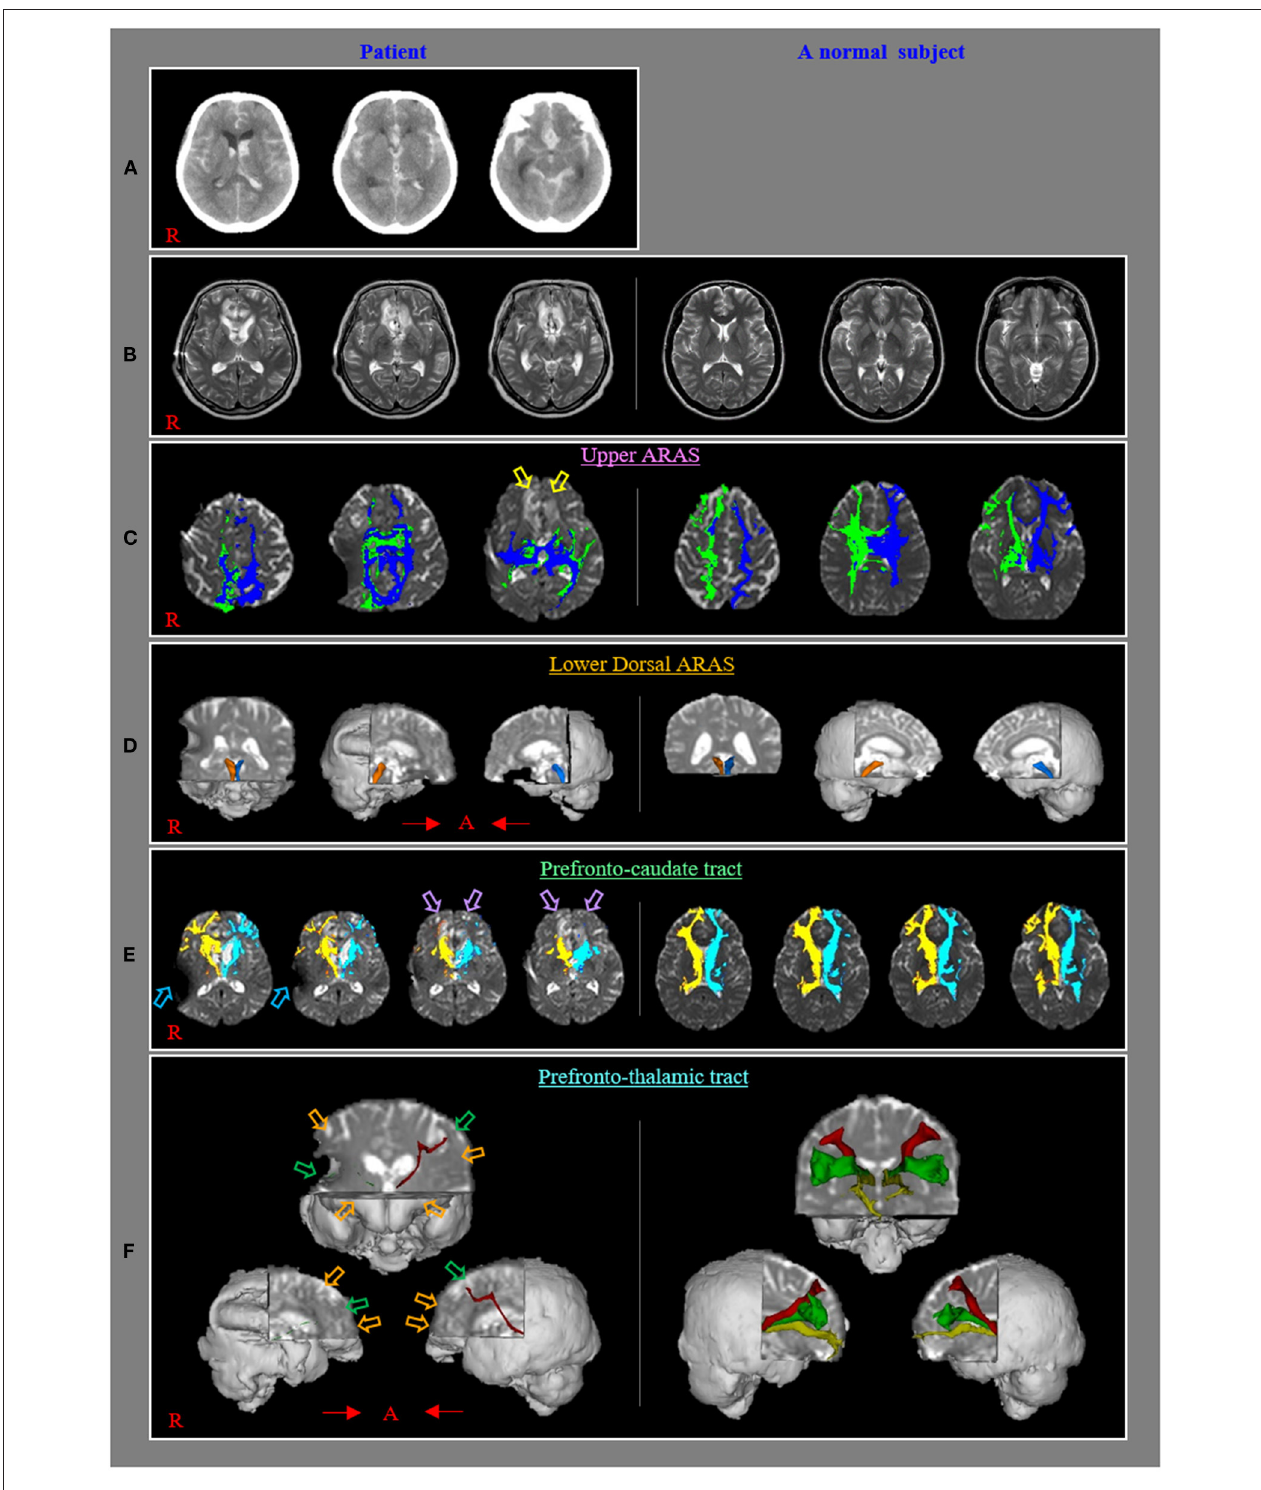
FIGURE 1 | (A) Brain CT images at onset reveal subarachnoid hemorrhage, intraventricular hemorrhage, and intracerebral hemorrhage in both basal forebrains. (B) T2-weighted brain MR images at 1 month after onset show leulomalactic lesions in both forebrains. (C) The upper ascending reticular activating system (ARAS) shows almost normal configurations in both hemispheres except for decreased neural connectivities to both basal forebrains (yellow arrows) compared with those of a